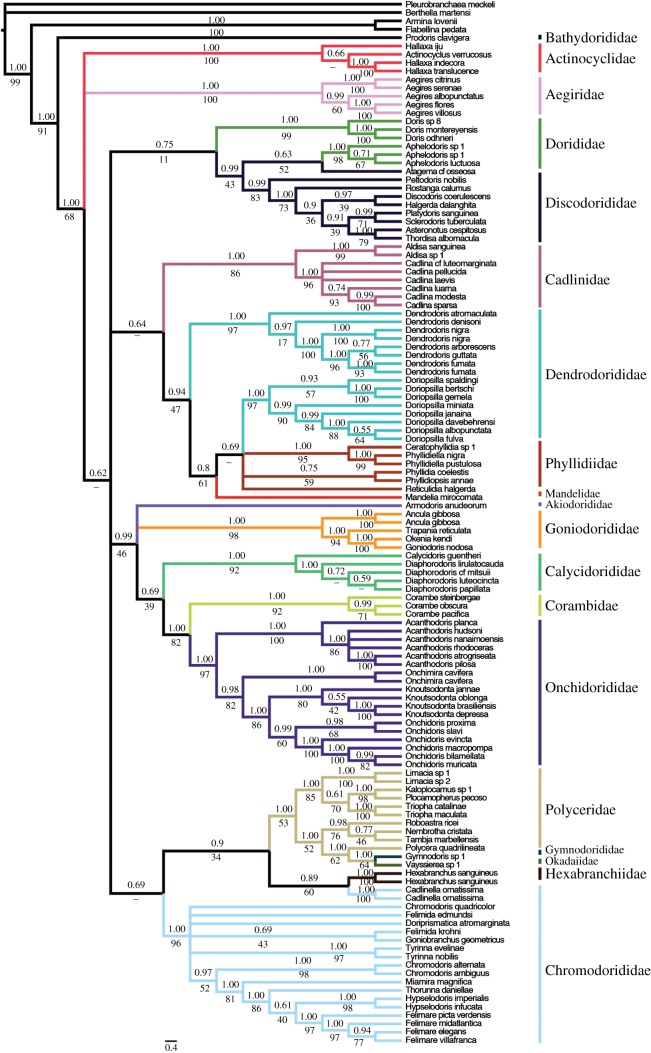
Phylogenetic estimate from Curated alignment. Topology represents Bayesian estimate, with posterior probabilities (pp) and non-parametric bootstrap (bs) support values depicted above and below each branch, respectively. Relationships that were not recovered by ML analysis are represented by dashes. Branches are coloured based on family designations and represented on the exterior of the phylogeny.